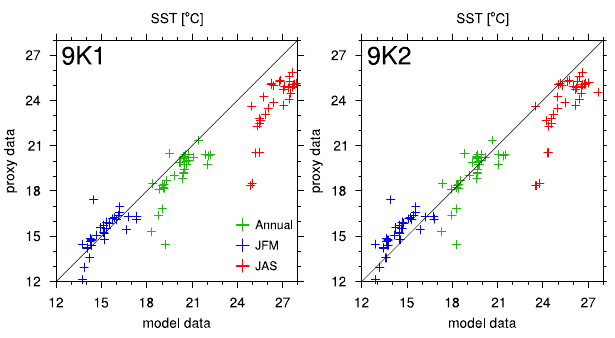
Fig. 18. Comparison of modelled SST with SST reconstructed from proxy data (Kucera et al., 2011) for 9K1 (left) and 9K2 (right). An- nual mean, winter (JFM) and summer (JAS) are